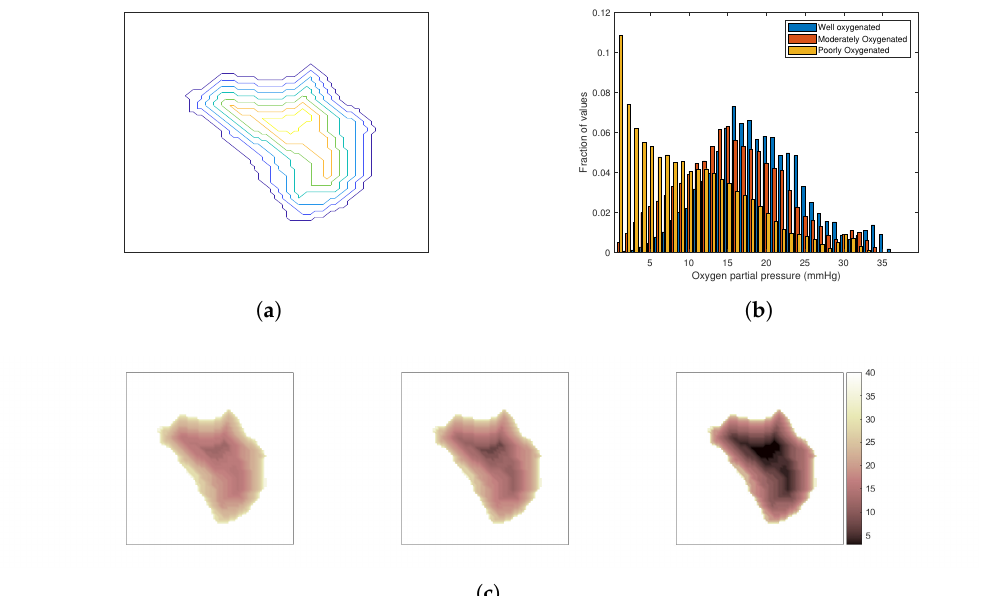
Figure 3. Modelling of the oxygenation level in the tumour. ( a ) A transverse cut of the iso-contour from the surface of the tumour. ( b ) Clinically representative histograms of pO 2 for a generic tumour under three different hypoxic conditions. ( c ) Mapped pO 2 distribution for those that are well-, moderately-, and poorly-oxygenated, respectively, from left to